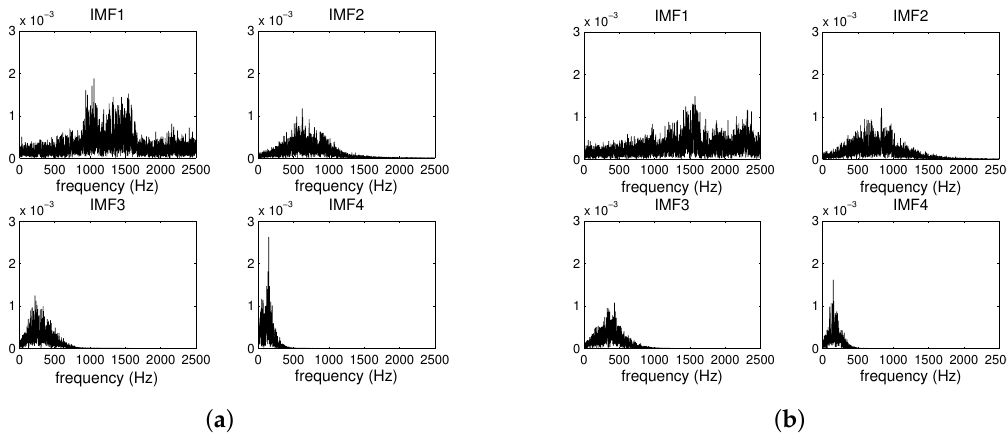
Figure 6. The first four intrinsic mode function (IMF) spectra of the pipeline leakage and non-leakage signal. ( a ) Leakage signal. ( b ) Non-leakage